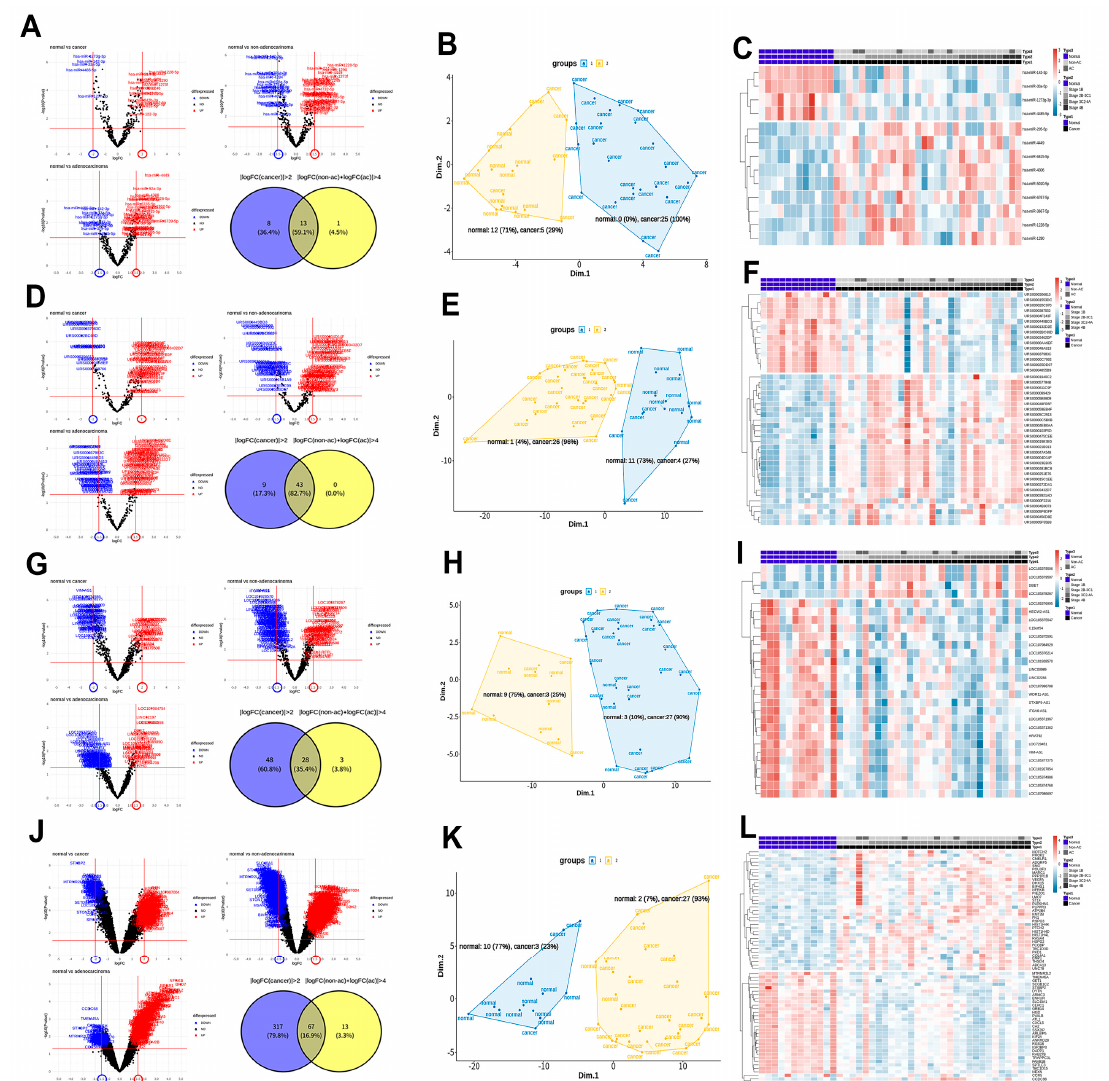
Figure 2. Statistical screening of miRNAs, piRNAs, lncRNAs, and mRNAs as markers for cervical cancer diagnosis. ( A ) Volcano plots and a Venn diagram of the selected 13 miRNAs. ( B ) A clustered multidimensional scaling (MDS) scatter plot for 42 samples using the 13 selected miRNAs. ( C ) A heatmap of the 13 miRNAs for the normal and cancer groups. ( D ) Volcano plots and a Venn diagram of the selected 42 piRNAs. ( E ) A clustered MDS scatter plot for the 42 samples using the 42 piRNAs. ( F ) A heatmap of the 42 piRNAs for the normal and cancer groups. ( G ) Volcano plots and a Venn diagram of the selected 28 lncRNAs. ( H ) A clustered MDS scatter plot for 42 samples using the 28 lncRNAs. ( I ) A heatmap of 28 lncRNAs for the normal and cancer groups. ( J ) Volcano plots and a Venn diagram of the selected 67 mRNAs. ( K ) A clustered MDS scatter plot for the 42 samples using 67 mRNAs. ( L ) A heatmap of the 67 mRNAs for the normal and cancer groups.